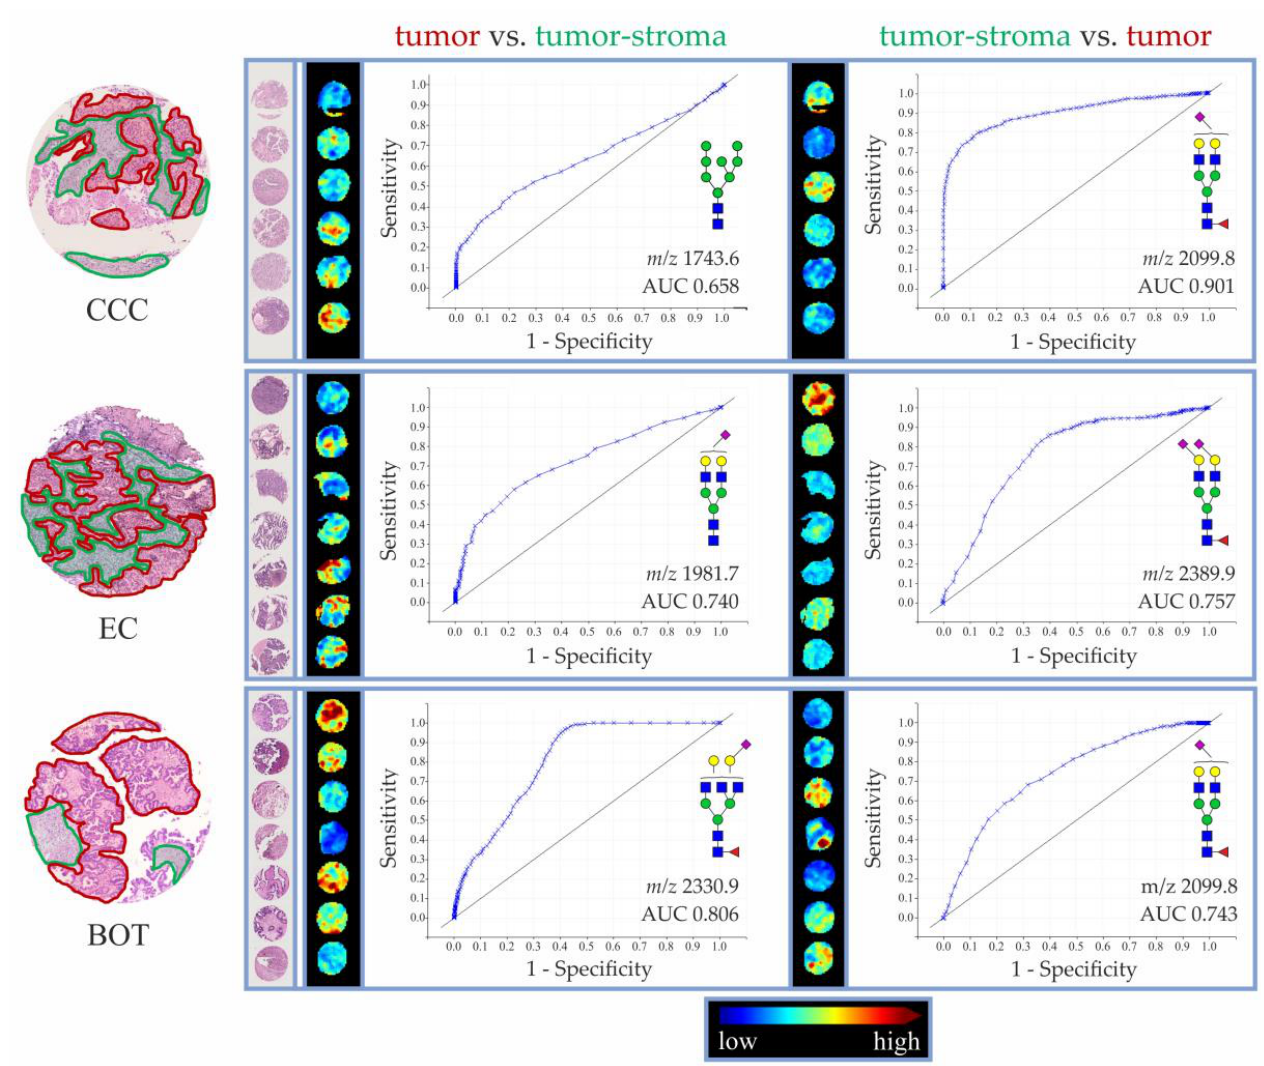
Figure 5. ROC curves and MALDI-MSI pictures of the most discriminatory N -glycan structures as determined for tumor and tumor-stroma in CCC ( n = 6), EC ( n = 7), and BOT ( n = 7) TMA specimens. Annotation of tissue regions is shown only for one representative core of each histotype. Tumor regions are marked in red, whereas tumor-stroma is marked in